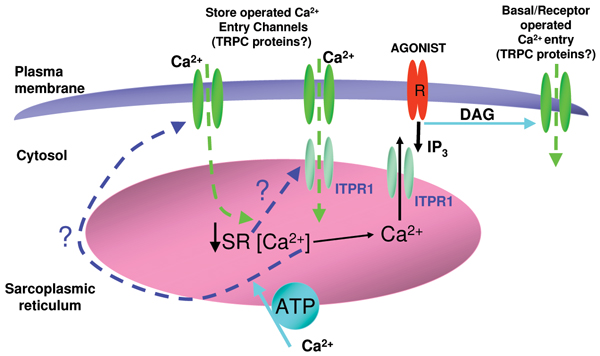
Calcium entry pathways associated with TRPC proteins. TRPC proteins are proposed to form store operated and basal/receptor operated plasma membrane calcium channels (depicted in green). Receptor operated calcium entry can occur when an agonist (e.g. oxytocin or PGF2α) binds to its receptor (R) resulting in an increase in diacylglycerol (DAG) and IP3 (inositol 1,4,5-trisphosphate). Interaction of IP3 with the receptor (ITPR) causes release of calcium for the sarcoplasmic reticulum (SR) and initiates store operated calcium entry.